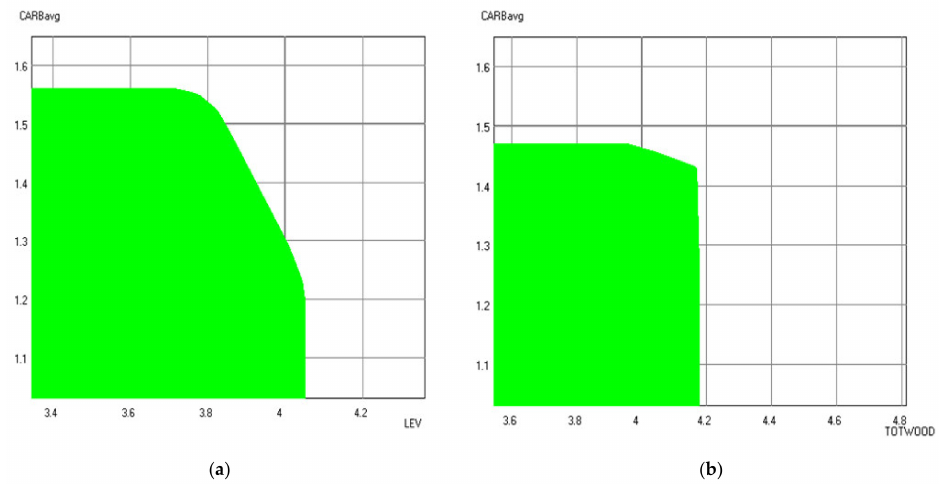
Figure 7. Illustration of two-dimensional decision map showing tradeoffs between aboveground carbon stock (CARBavg, 10 7 kg) and ( a ) LEV (10 9 ETB) and ( b ) total harvested wood volume (TOTWOOD, 10 5 m 3 ).